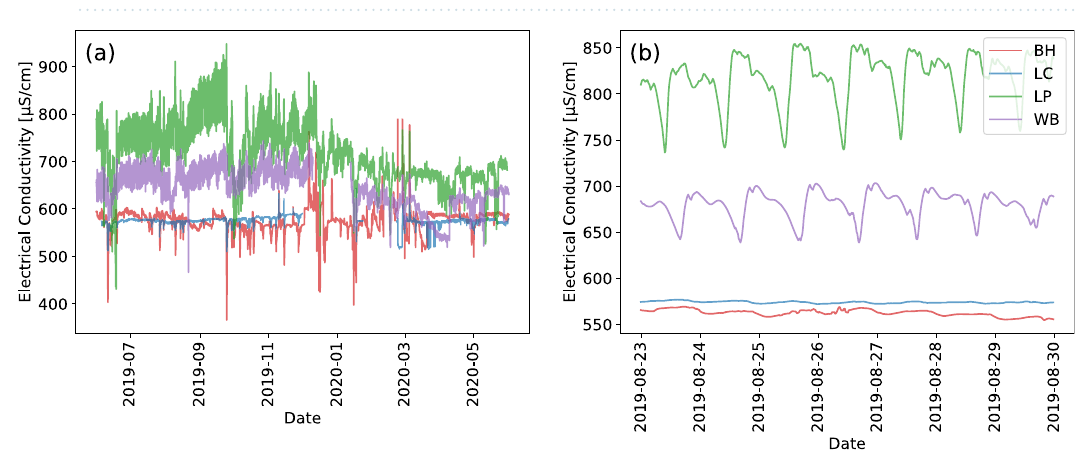
Figure 2. Electrical conductivity time series ( a ) June 2019 to 2020; and ( b ) 23 August to 30 August